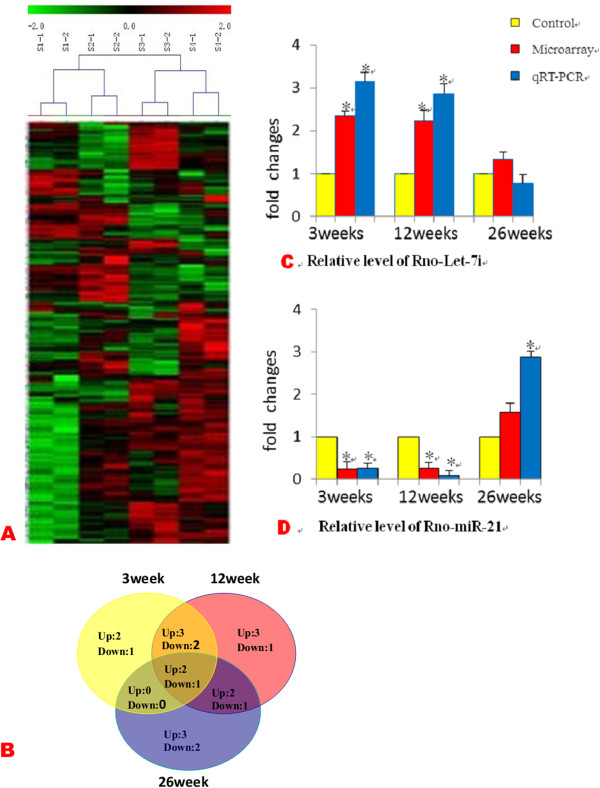
miRNA expression in the rat lung after irradiation. (A) Unsupervised hierarchical clustering of differentially expressed miRNAs in early (3w), middle (12w) and late (26w) stages of RILI. Red indicates higher expression and green indicates lower expression in irradiated lungs. Black means no expression difference. (B) Overlaps of co-regulated miRNAs (>2.0 fold) across various post-irradiation time courses. Data shown are real numbers of up-regulated (Up) and down-regulated (Down) miRNAs. The numbers in the overlapped areas represent the number of differentially transcribed miRNAs shared by two or three groups. (C, D) qRT-PCR and microarray results of miRNA (Rno-miR-21and Rno-Let-7i) expression level at each post-irradiation time point. Results are expressed as relative quantifications (RQ) of the miRNA expression level in each sample relative to non-irradiated controls, and normalized to U6 snRNA. Each reaction was performed in triplicate and the average CT was used for RQ calculation. *p < 0.05, in 2-tailed student’s t test when compared to non-irradiated controls.